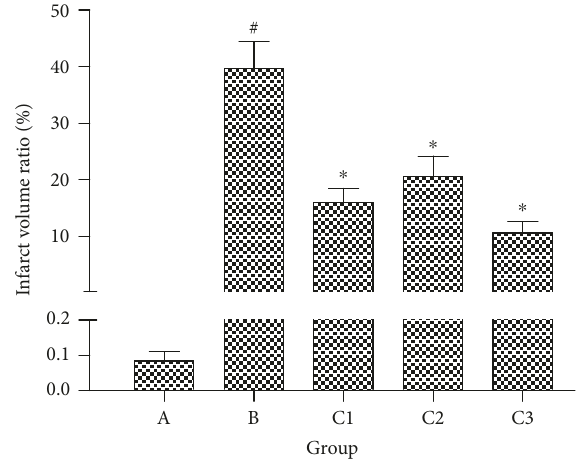
Figure 5: Infarct volume ratio of the brain tissue in each group within 5 days after CIRI. # P < 0 01 versus group A, ∗ P < 0 01 versus group B. Data are presented as the mean ± standard deviation; n = 7 . Group A: sham-operated; group B: control; group C1: pretreatment; group C2: treatment; group C3: pretreatment +treatment.